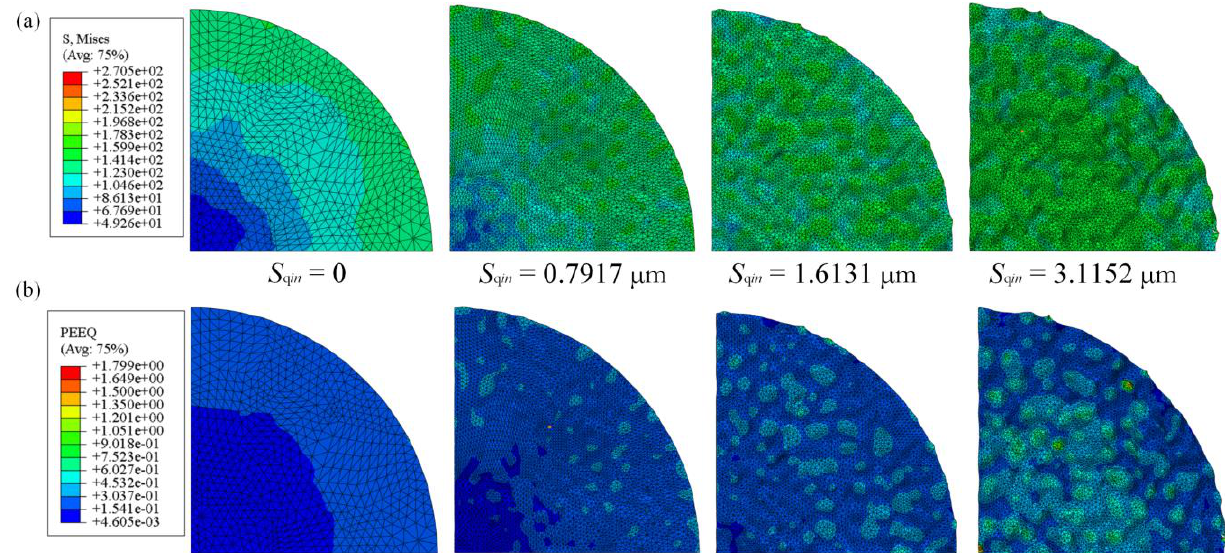
Figure 5. The effect of initial surface roughness on ( a ) the stress distribution and ( b ) the strain distribution under different values of initial surface roughness.